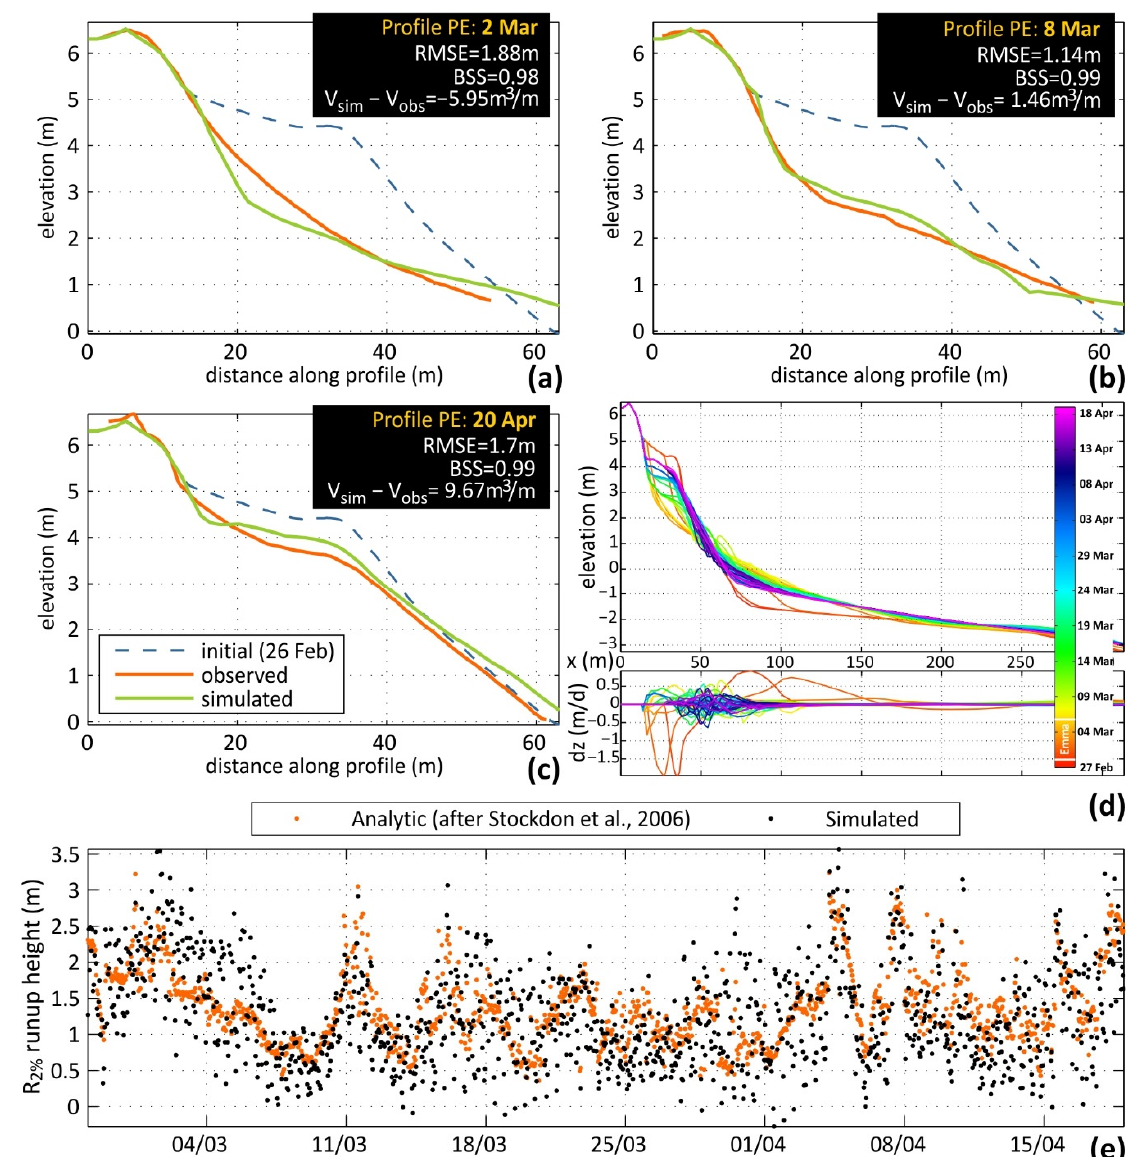
Figure 8. Calibration results for profile PE (see Figure 1 for location): ( a – c ) show the goodness of fit between simulated (green line) and observed (orange line) profiles for 2 and 8 March and 20 April, respectively (RMSE, BSS and total volume difference between simulation and observation (V sim − V obs ) are given in the legend); ( d ) shows profile changes (top panel) and alongshore elevation change rates (in m/d; bottom panel) with time (color bar; the Emma storm duration is noted); the time-series of theoretic (orange dots, after [46]) and simulated (black dots) are given in ( e ).